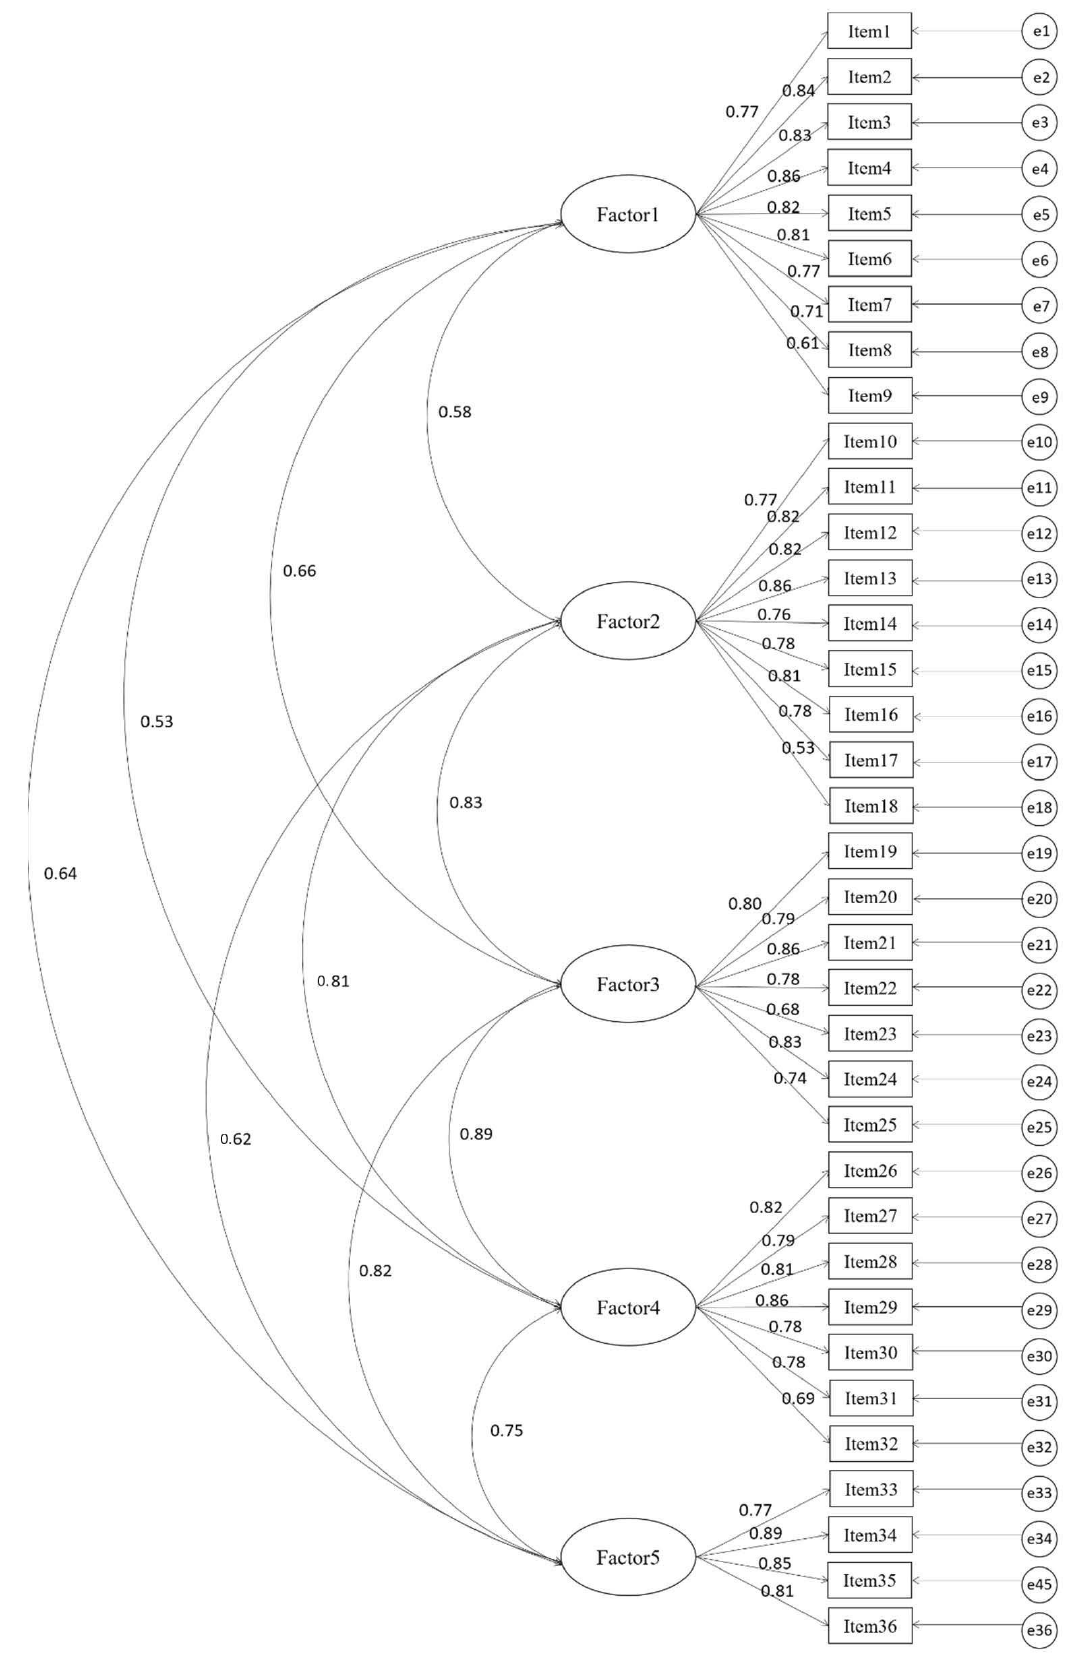
Figure 1. Measurement model of the Korean version of Holistic Nursing Competence Scale (HNCS).